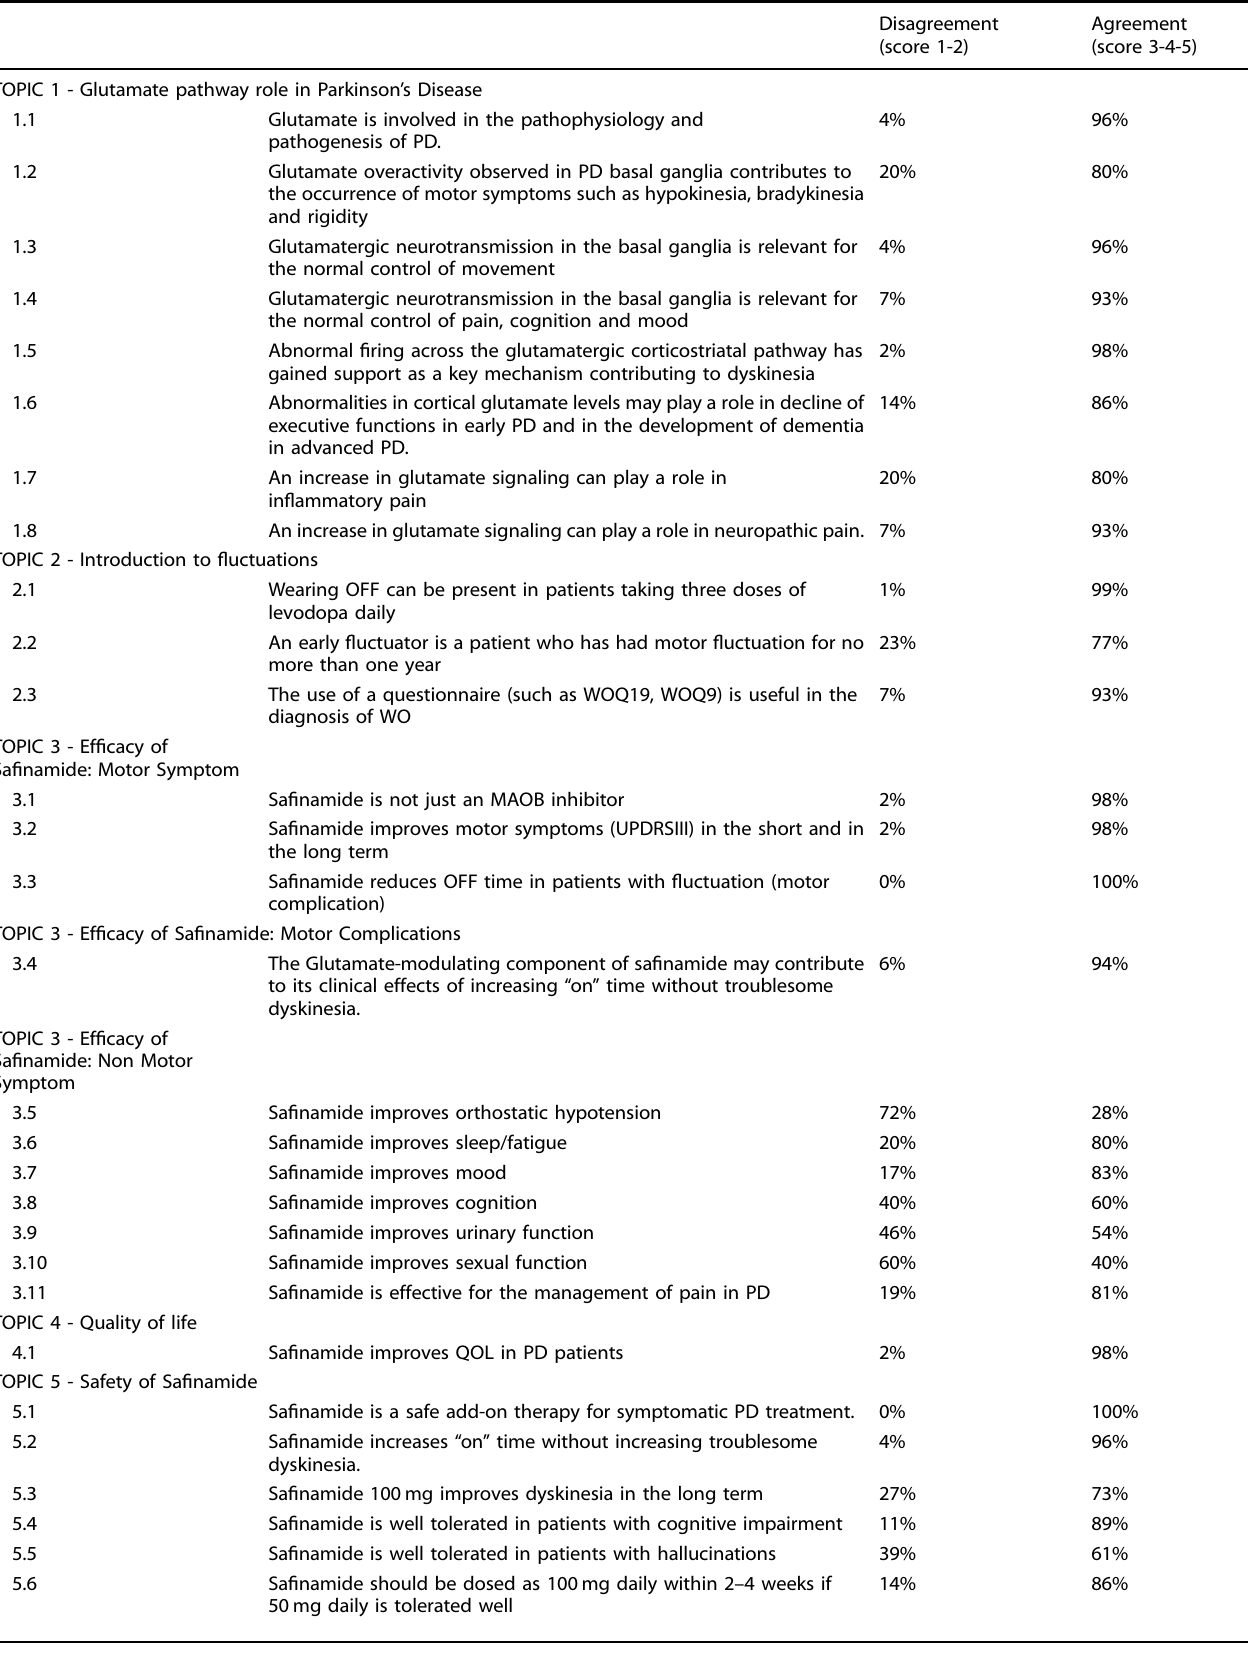
Table 1. Consensus score.